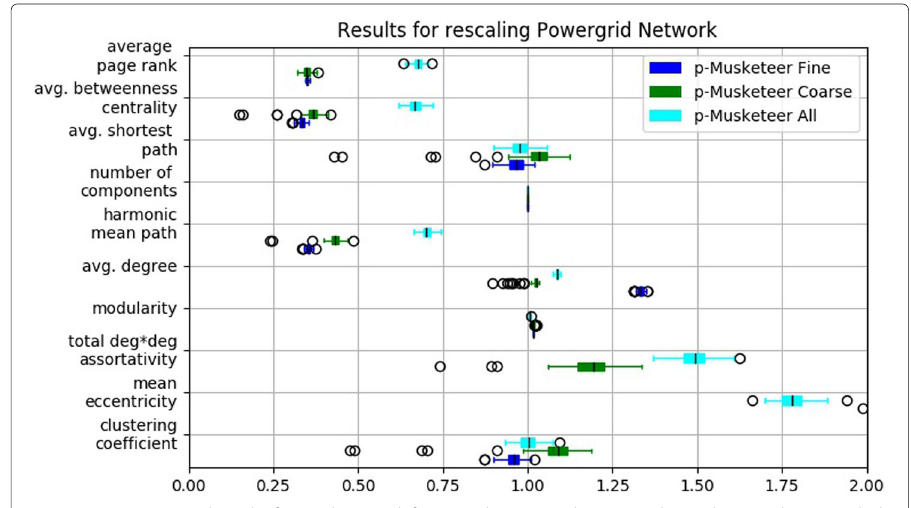
Fig. 17 Computational results for road network from roadNet-TX with 2001 nodes and 2957 edges rescaled to at least 6000 nodes and 6500 edges